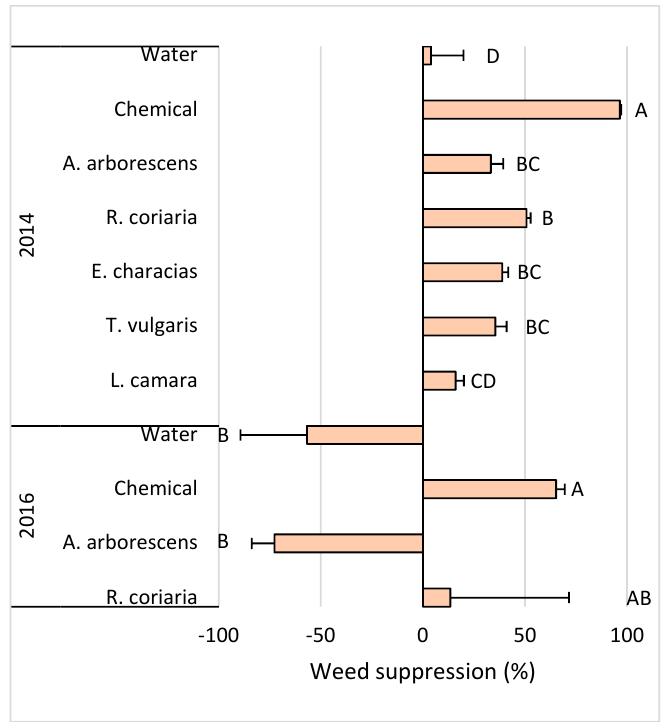
Figure 4. Weed suppression indices (S t %) calculated in 2014 and 2016 for all treatments, including chemical and water control. Error bars indicate the standard deviation of each mean. In each year, values accompanied by the same letter are not different at p ≤ 0.05 (HSD Tukey’s test).